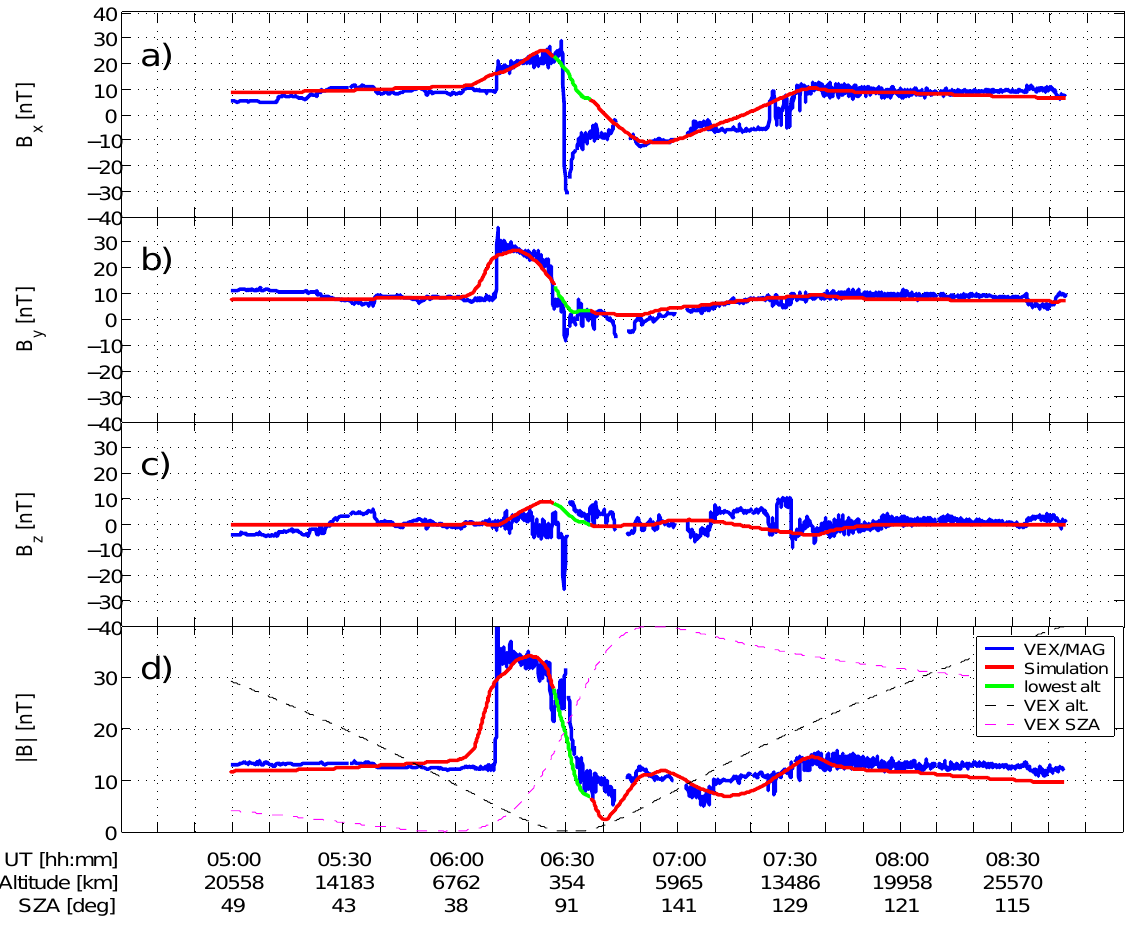
Fig. 2. A comparison of the magnetic field observed by VEX/MAG (blue line) and the magnetic field from the nominal HYB-Venus simulation run (red line) along the orbit shown in Fig. 1. The lowest panel includes the spacecraft’s altitude from the planetary surface (dashed black line) and solar-zenith angle (dashed magenta line) information. The green line in the simulation plot denotes the part of the orbit below 500km (less than a simulation grid cell)